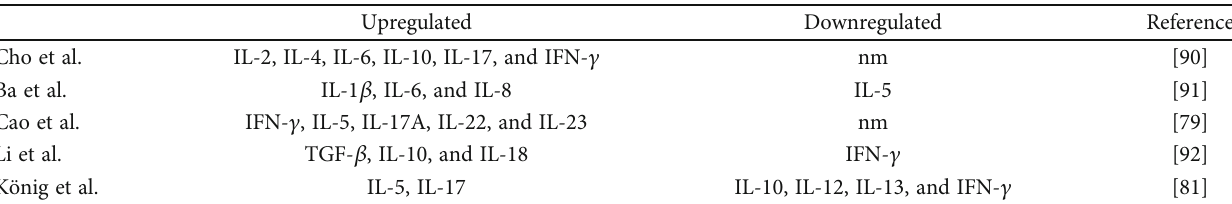
Table 1: Changes of cytokines in patients with CRSwNP in di ff erent studies. Upregulated Downregulated